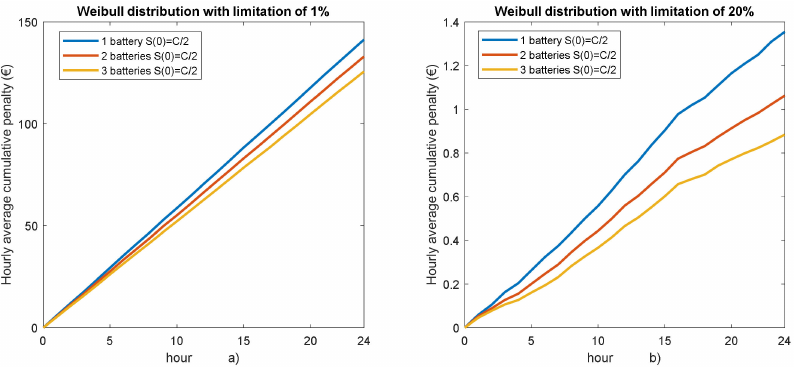
Figure 12. Hourly average cumulative theoretical penalty in 1 day with the Weibull distribution and the ramp-rate percentage limitations of 1% ( a ) and 20% ( b